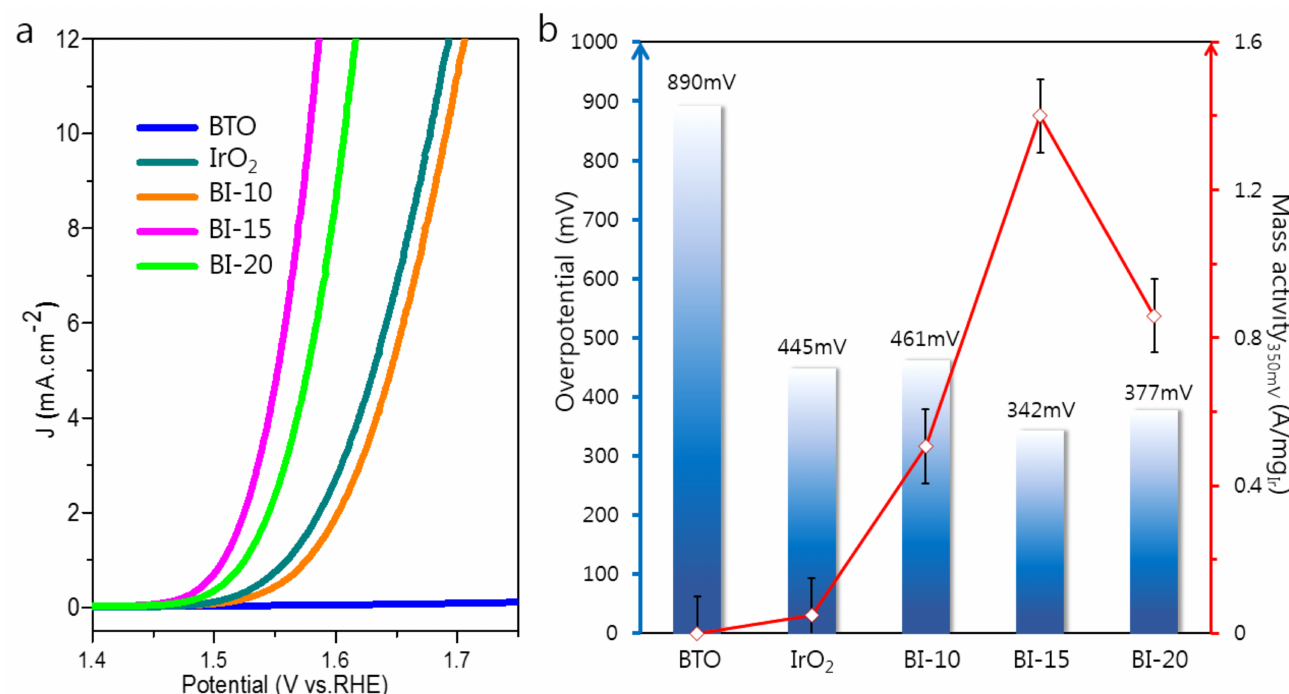
Figure 3. ( a ) LSV curves to evaluate OER activity, collected at the scan of 5 mV.s − 1 for BTO, IrO 2 , BI − 10, BI − 15, and BI − 20. ( b ) Bar graph showing required overpotentials to reach 10 mA cm − 2 and Ir mass activity at the overpotential of 350 mV (vs RHE) of various catalysts.